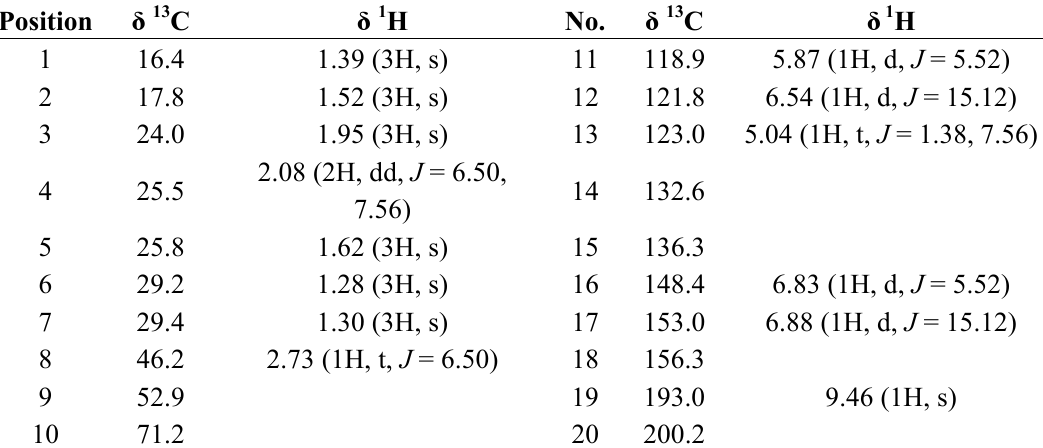
Table 1. 1 H and 13 C-NMR correlation based on HETCOR spectrum for cubelin in CDCl ( δ in ppm, J in